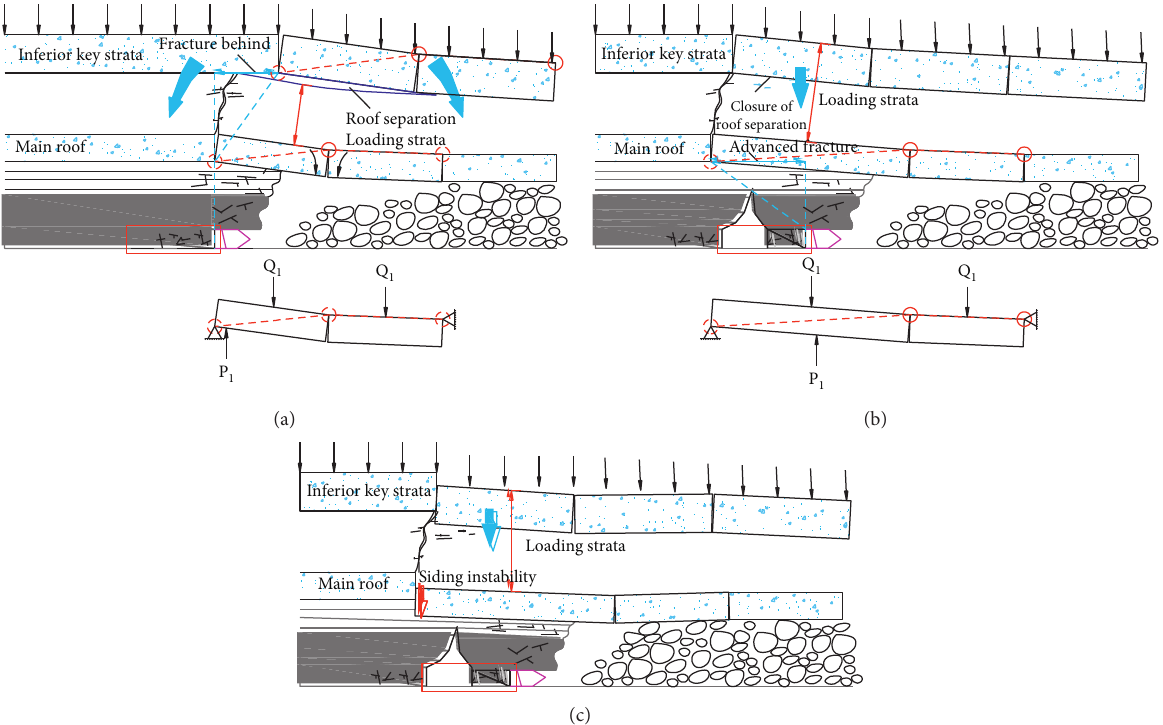
Figure 6: The overlying rocks evolution laws of long-wall face across to abandoned roadway. (a) Normal advancing stage, (b) abnormal advancing stage (before siding instability), and (c) abnormal advancing stage (after siding